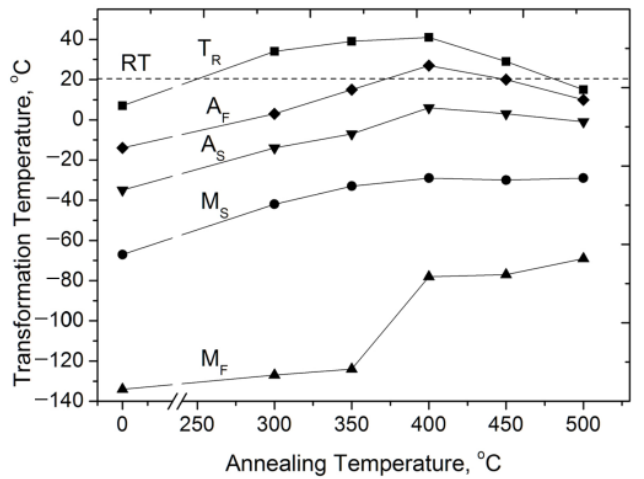
Figure 1. Effect of aging temperature on the critical temperatures of the start of martensitic transformations B2 → R (T R ) as well as the onset (M S , A S ) and finish (M F , A F ) of direct (M S , M F ) and inverse (A S , A F ) martensitic transformations B2 → B19′ .